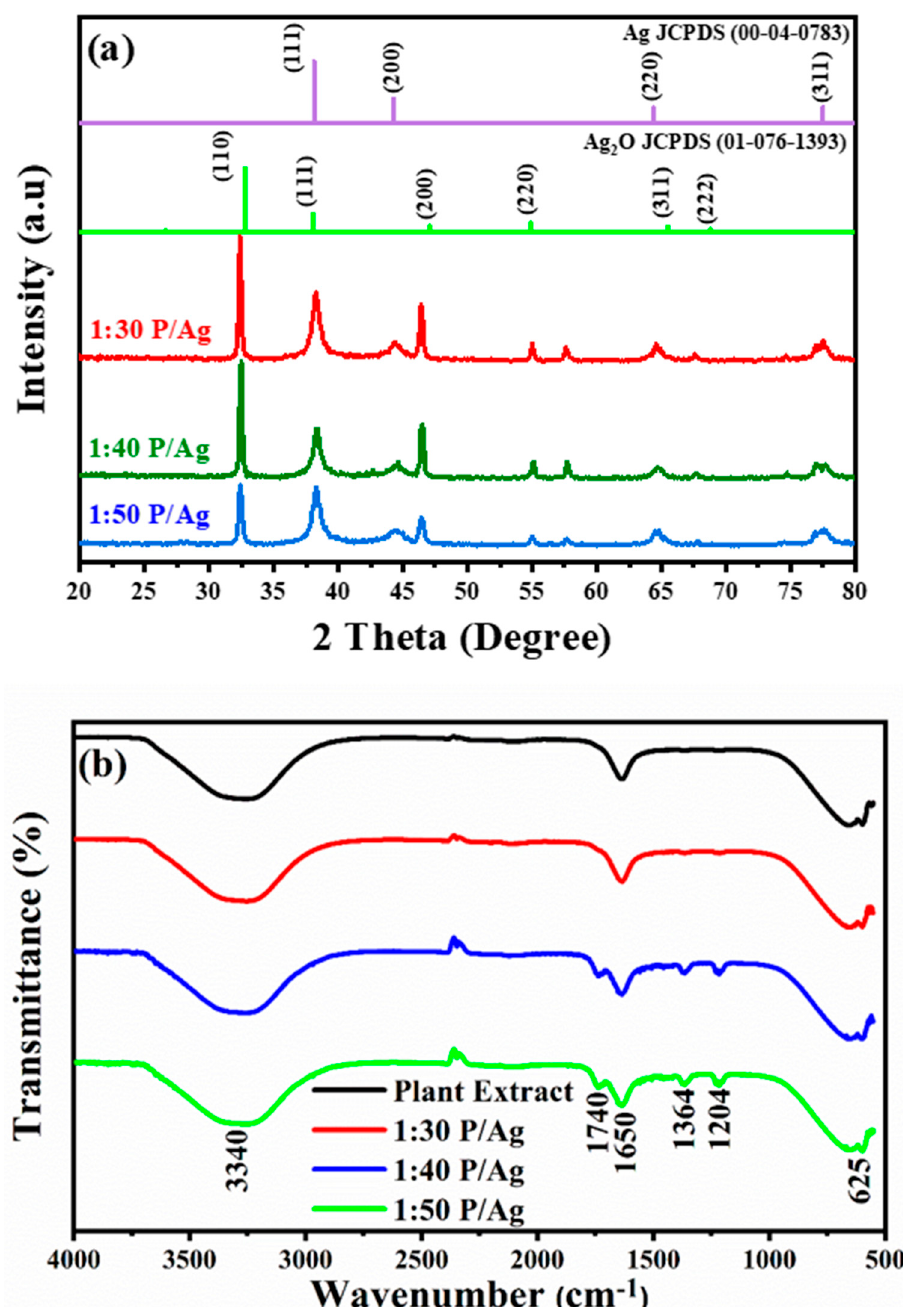
Figure 1. ( a ) XRD patterns; ( b ) FTIR spectra of Ag/Ag 2 O at different volume ratios of Phoenix dactylifera L. extract.